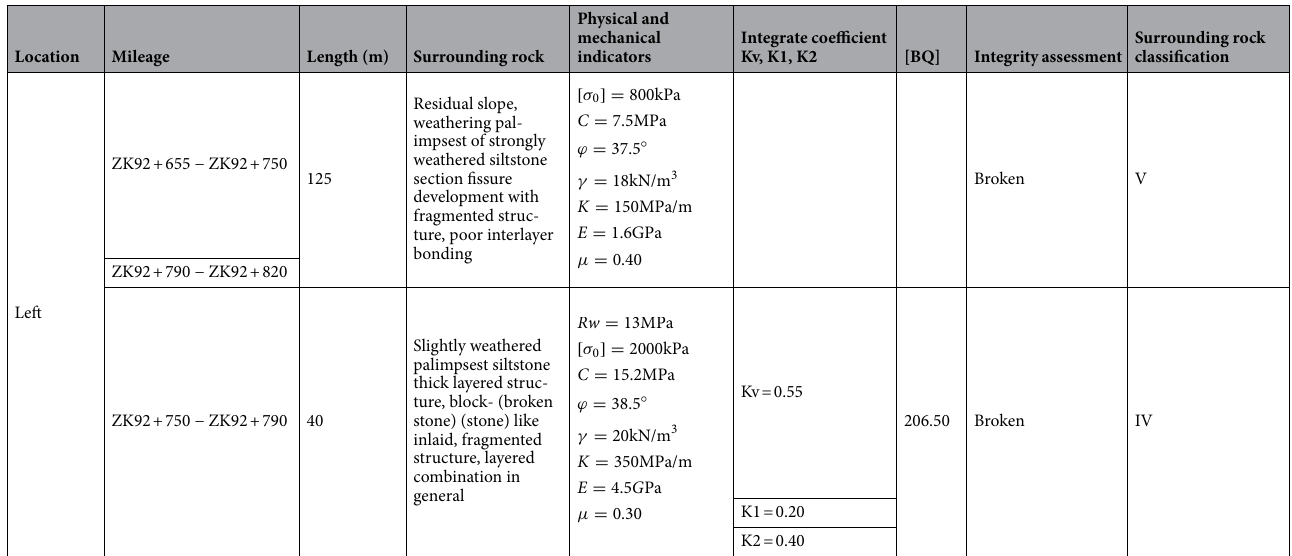
Table 4. Rock characteristics and